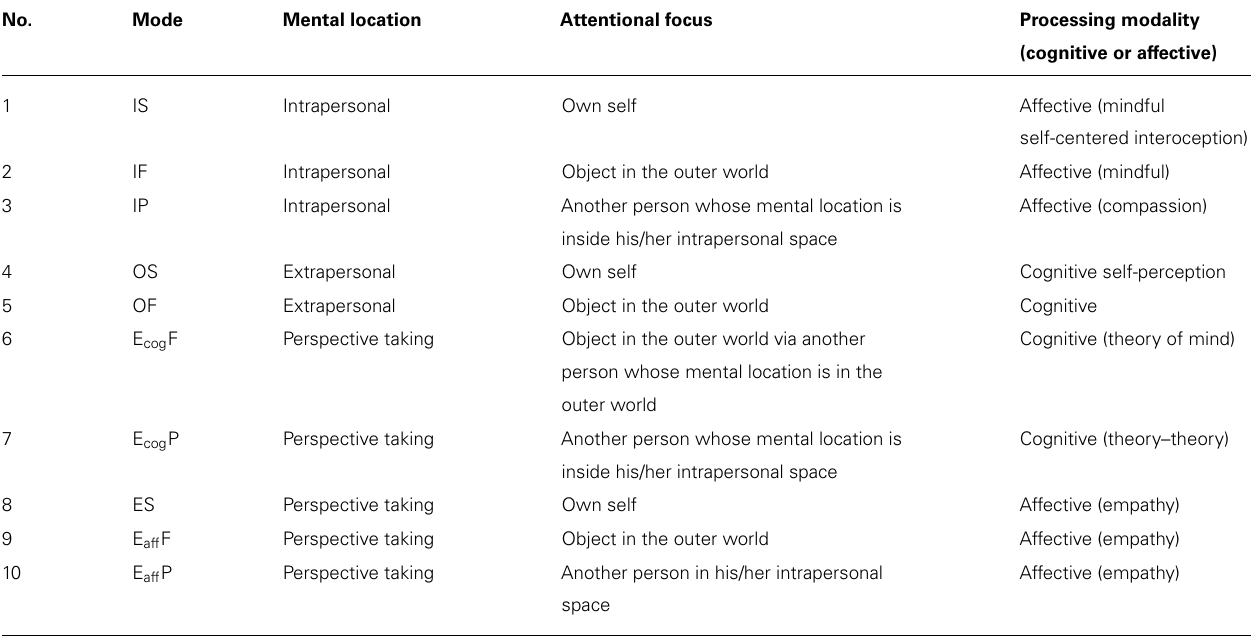
Table 1 | Overview of mental localization, attentional focus, and processing modality according to the BBAM.